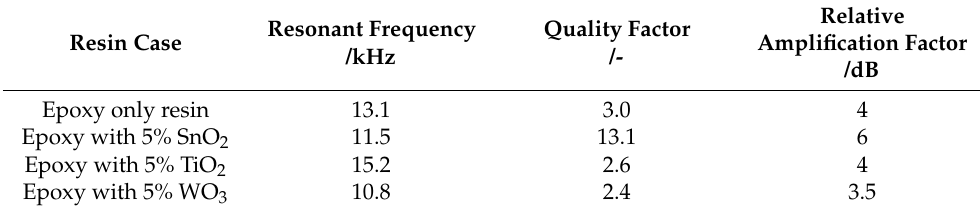
Table 1. Characteristics of the mechanical